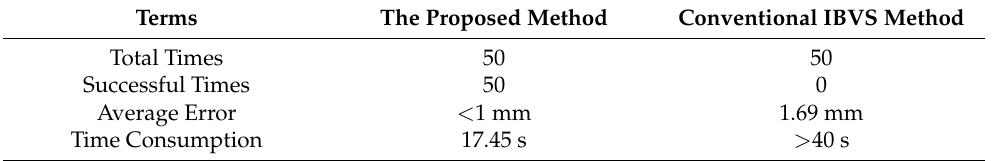
Table 4. Results of 50